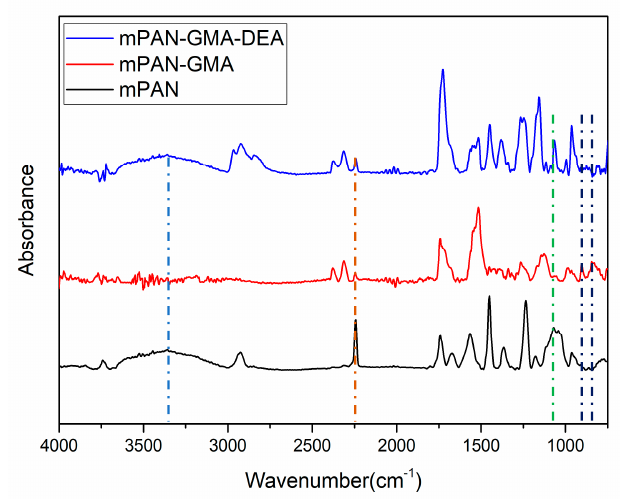
Figure 2. FTIR spectra of hydrolyzed PAN membrane (black), PAN membrane modified with GMA (red) and membrane modified with GMA-DEA (blue).